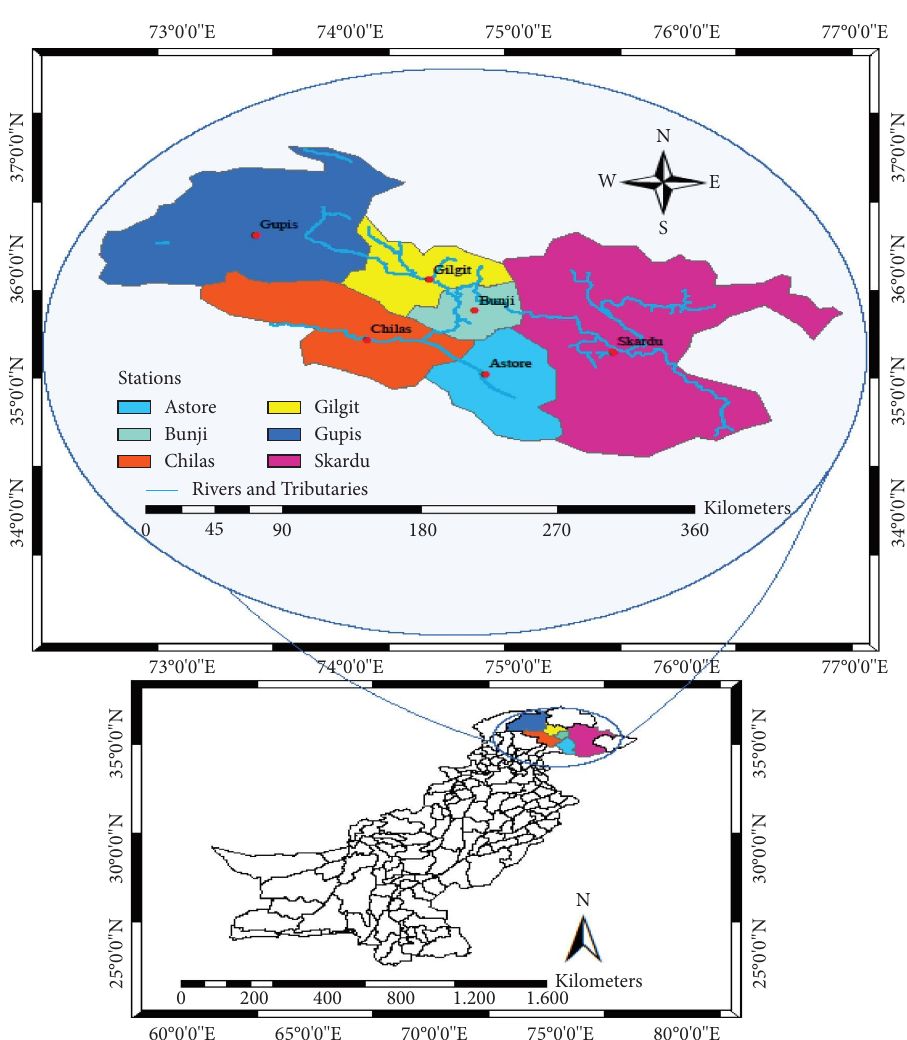
Figure 1: Te map of the study region and distribution of meteorological stations. Table 1: Descriptive statistics of average annual meteorological variables (precipitation and minimum and maximum temperature), regional spatial characteristics, and climate (K ӧ ppen classifcation). Precipitation Temp. min Temp. max Station Latitude